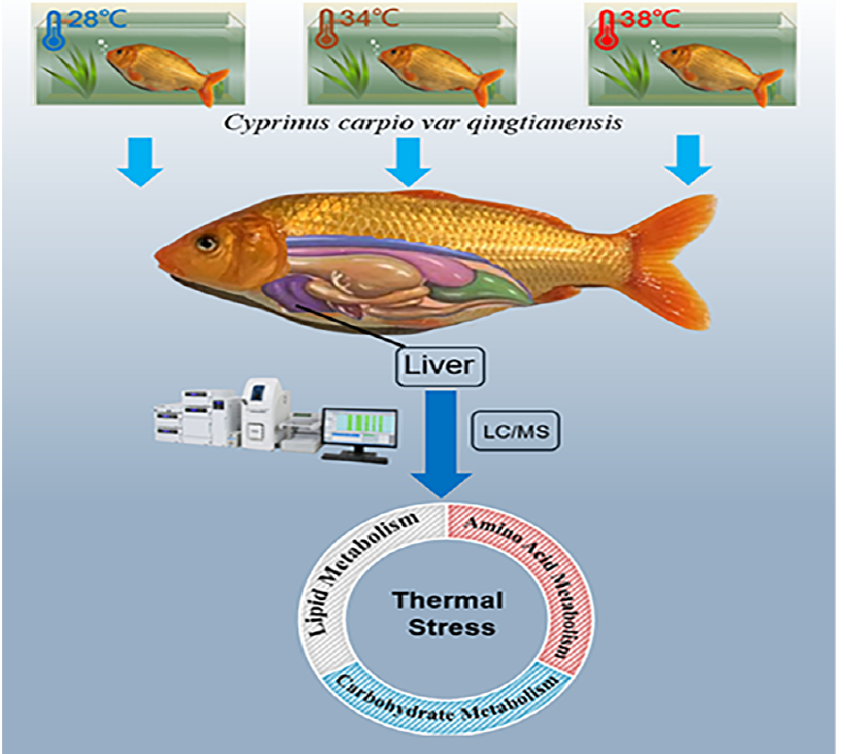
Figure 1. The experimental model of the effects of thermal stress on liver metabolomics of Cyprinus car pio var qingtianensis.